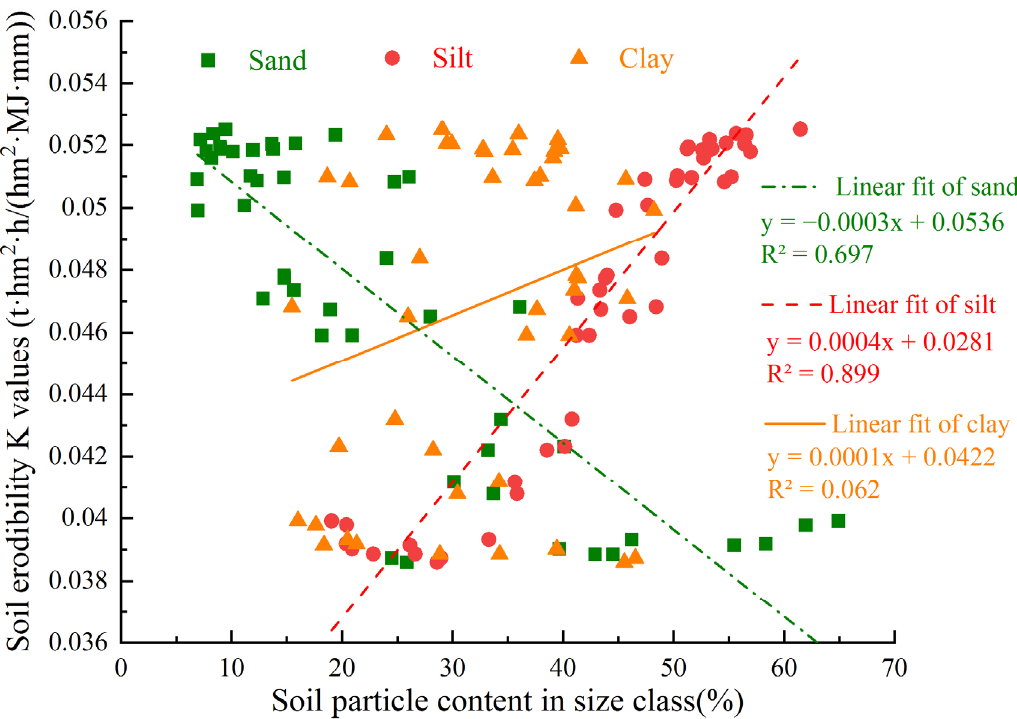
Figure 6. Soil erodibility K values as functions of soil sand, silt, and clay contents. Table 5. Descriptive statistics of K values for different land use types (t · hm 2 · h/(hm 2 · MJ ·